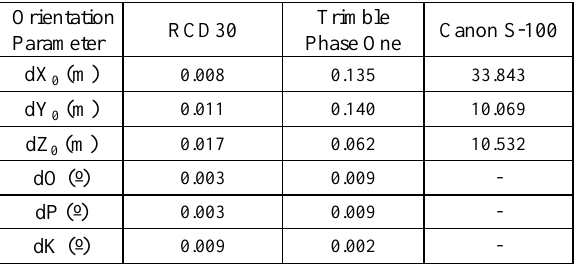
Table 5. A posteriori external orientation parameters (Direct Georeferencing)